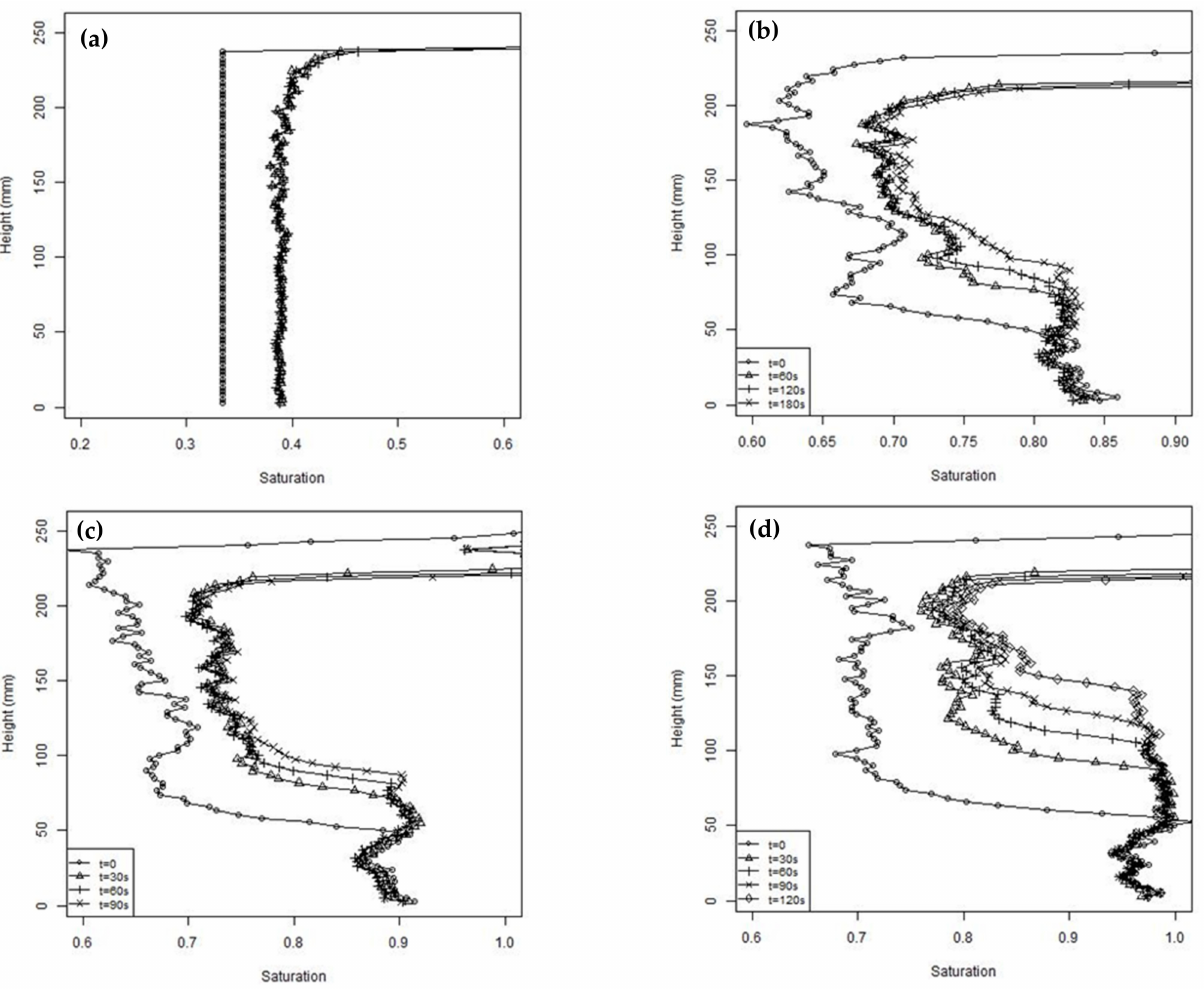
Figure 7. Saturation profiles at different times during the unsaturated tests ( a ) test 2, ( b ) test 3, ( c ) test 5, and ( d ) test